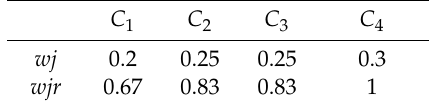
Table 6. The relative weight of each attribute C j .